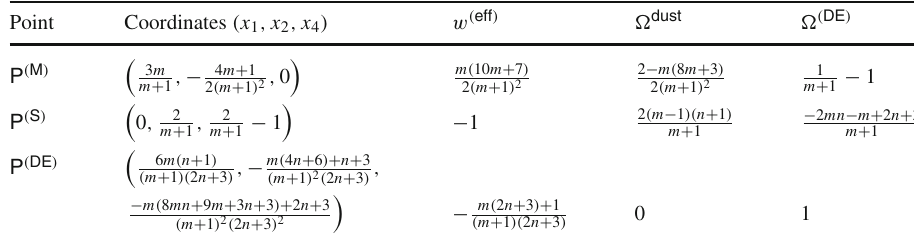
Table 2 The fixed points solutions of f ( R , T ) = R α + ( − T ) β